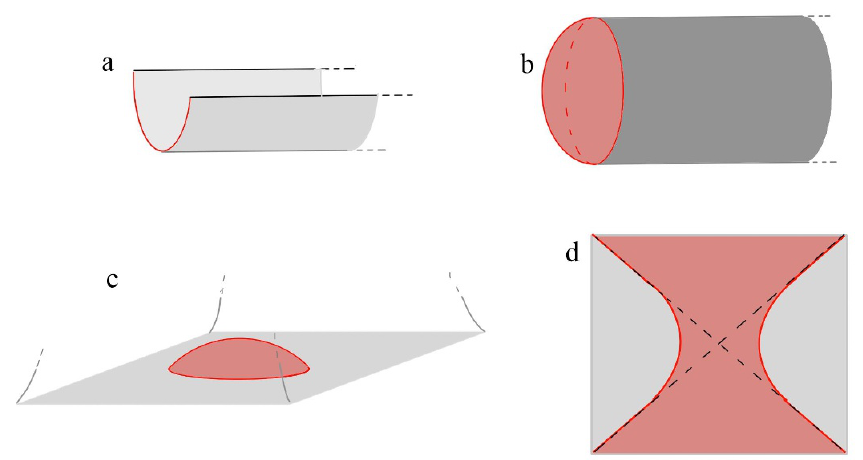
Figure 4 . a) BCFT path integral de(cid:12)ning the thermo(cid:12)eld double state of two 1+1 dimensional BCFTs. b) Euclidean geometry dual to the BCFT thermo(cid:12)eld double. The red surface is